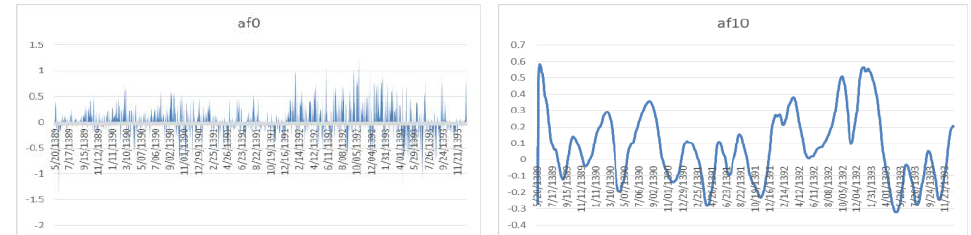
Figure 3. original series and long-term series of Beta of food